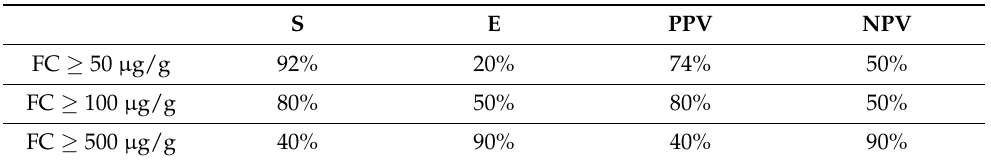
Table 3. Performance characteristics of Fecal Calprotectin for the detection of small bowel lesions with small bowel capsule endoscopy.